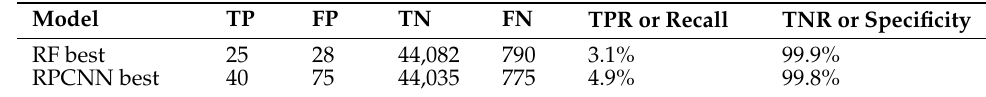
Table 8. Classification results in terms of True Positive (TP), False Positive (FP), True Negative (FN), False Negative (FN), True Positive Rate (TPR) and True Negative Rate (TNR) of the best-performing RF and RPCNN models. The thresholds for both models were obtained from the ROC curves so that the beam time saved is maximized, with 0.70 for the RF and 0.65 for the